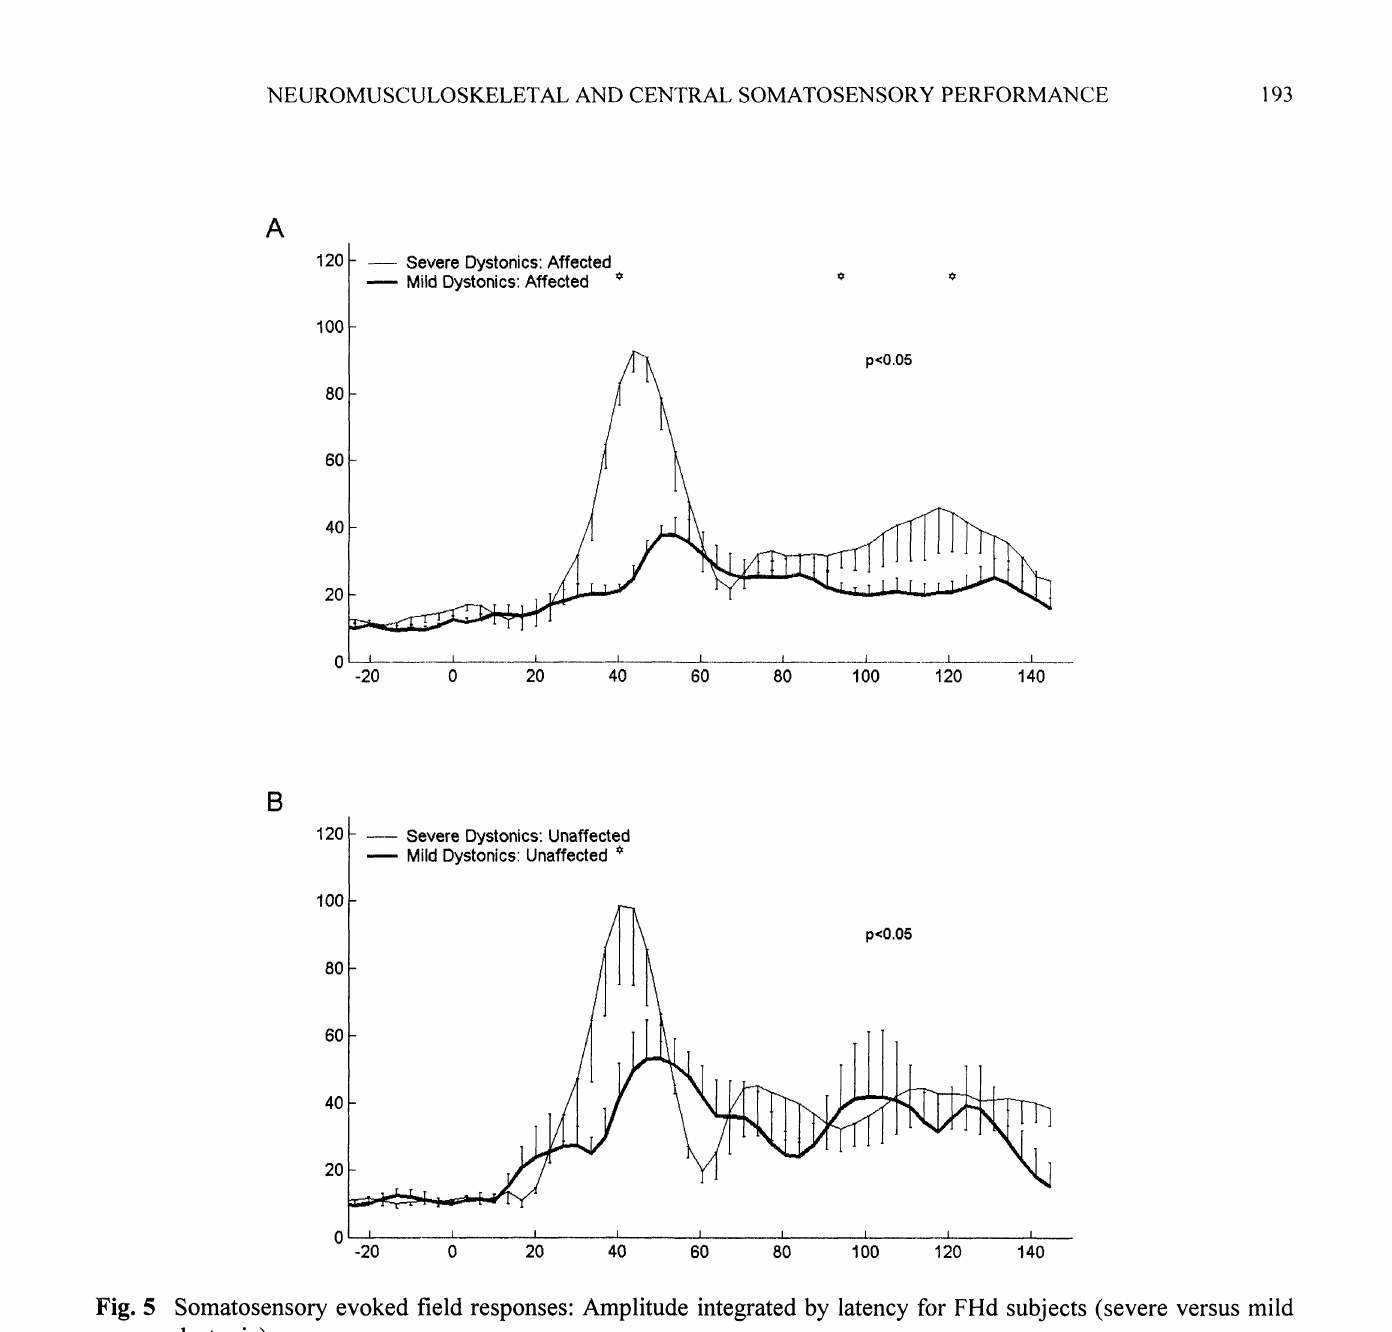
Fig. 5 Somatosensory evoked field responses: Amplitude integrated by latency for FHd subjects (severe versus mild